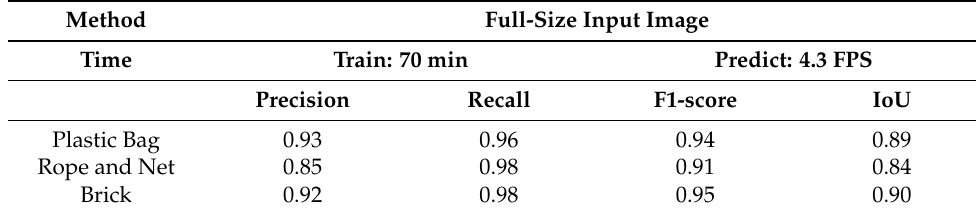
Table 6. Results of full-size input images.